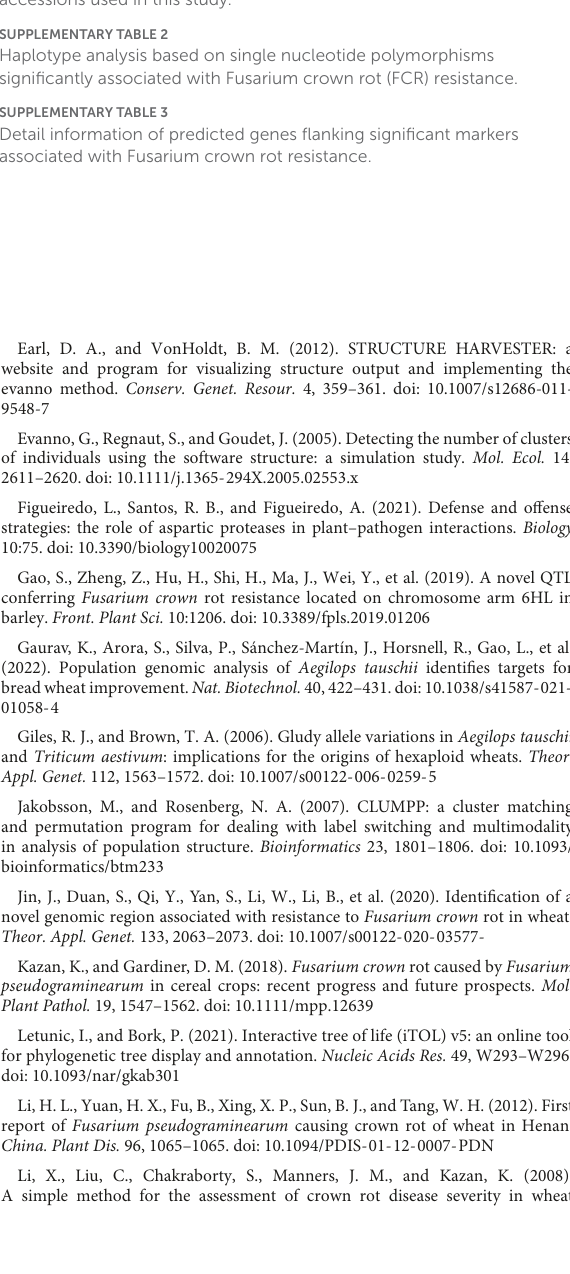
SUPPLEMENTARYTABLE2 Haplotype analysis based on single nucleotide polymorphisms significantly associated with Fusarium crown rot (FCR)